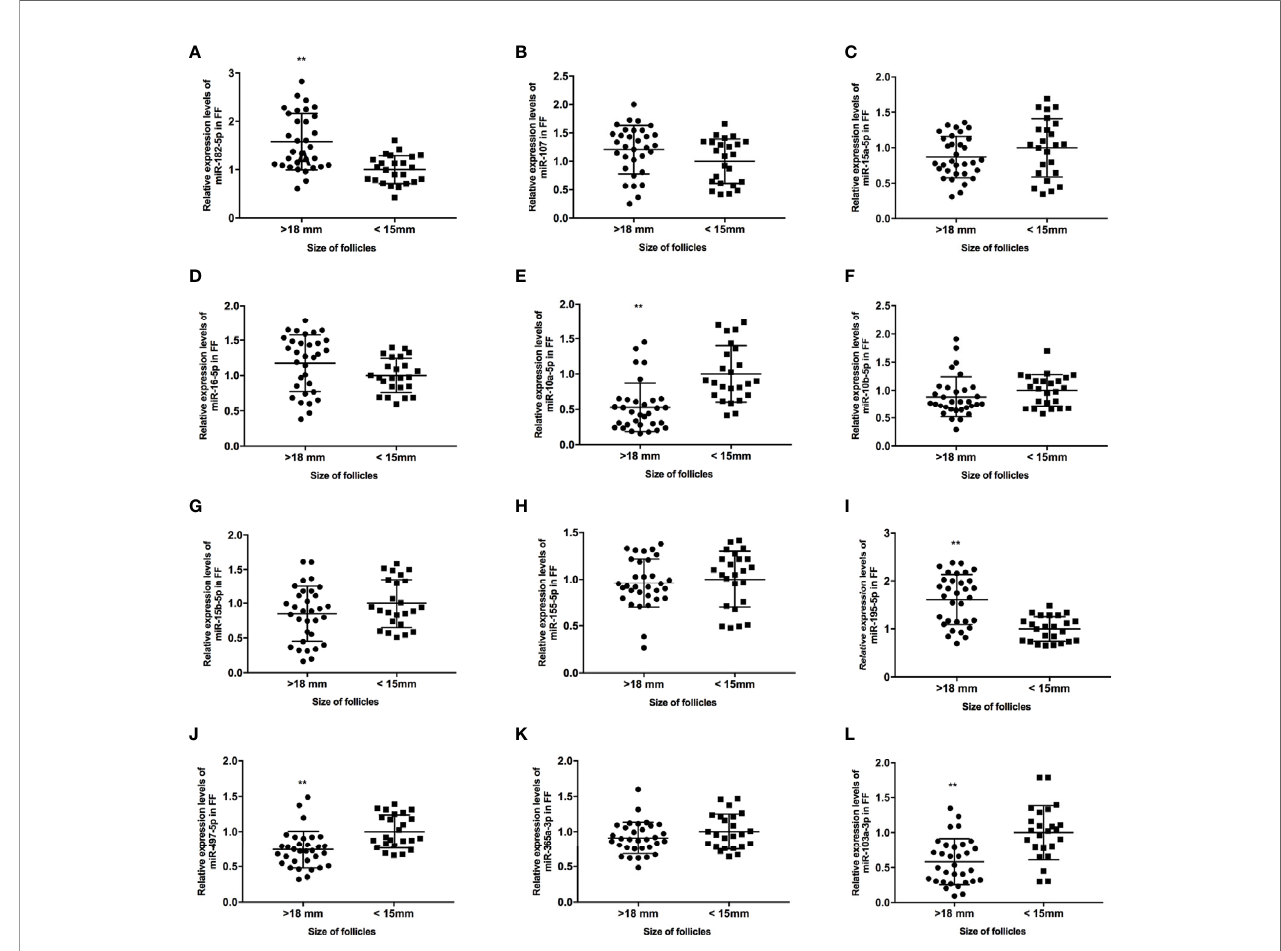
FIGURE 2 | The expression levels of candidate miRNAs in FF from mature (>18 mm) and immature (<15 mm) follicles (A – L) . **, P < 0.01. Data are presented as the mean ± standard deviation. Student ’ s t-test or Mann-Whitney tests were performed to determine the differences between two groups based on the normality of the distribution of